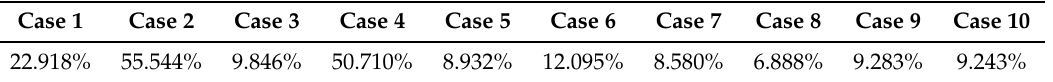
Table 9. Improvement of objective functions for GROM between scenario 1 and scenario 3.